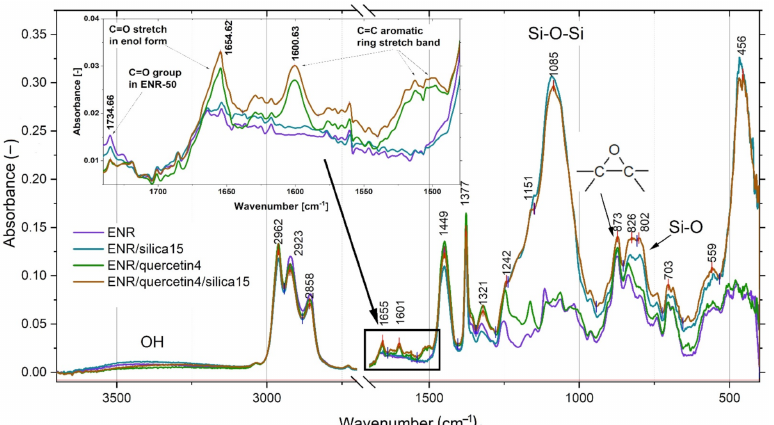
Figure 6. FT-IR spectrum of ENR/quercetin4/silica15 compared with spectra of pure ENR, ENR/silica15 and